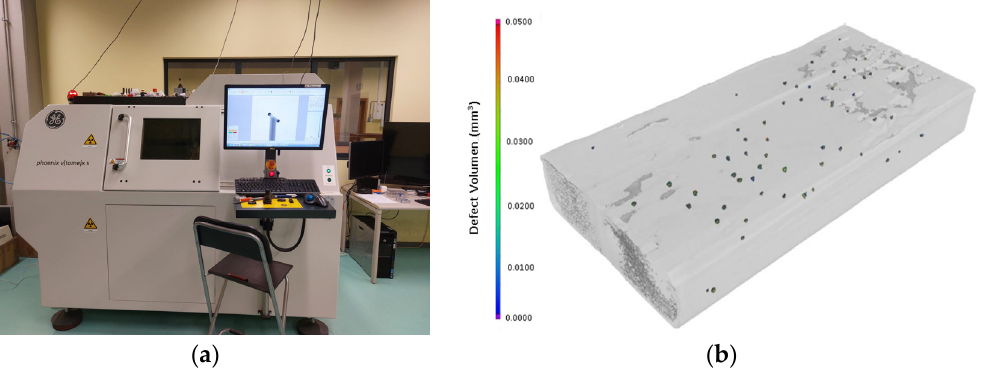
Figure 4. ( a ) CT GE Phoenix v|tome|x S in the Metrology Laboratory of Poznan University of Technology, ( b ) Porosity analysis of the A1.2 specimen.